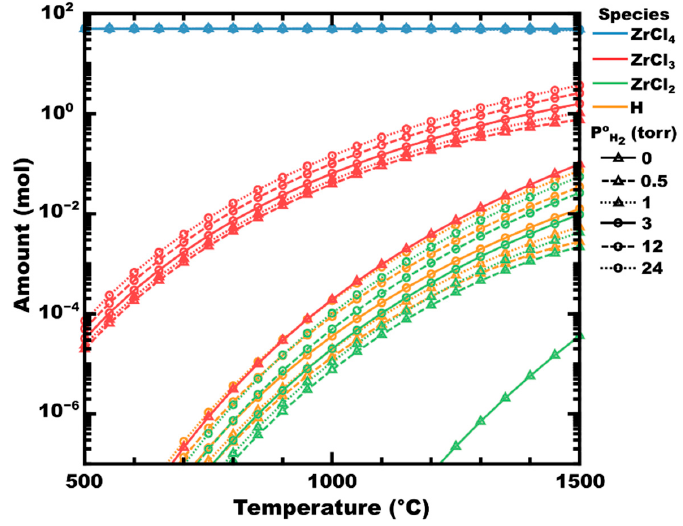
Figure 1. Graph of the moles of zirconium chlorides in ZrCl 4 -H 2 mixtures at equilibrium as P° H2 increases, at a total pressure of 50 torr. Line styles (shown in black) indicate P° H2 . Calculated in FactSage™ 8.1 (Thermfact Ltd. and GTT-Technologies).